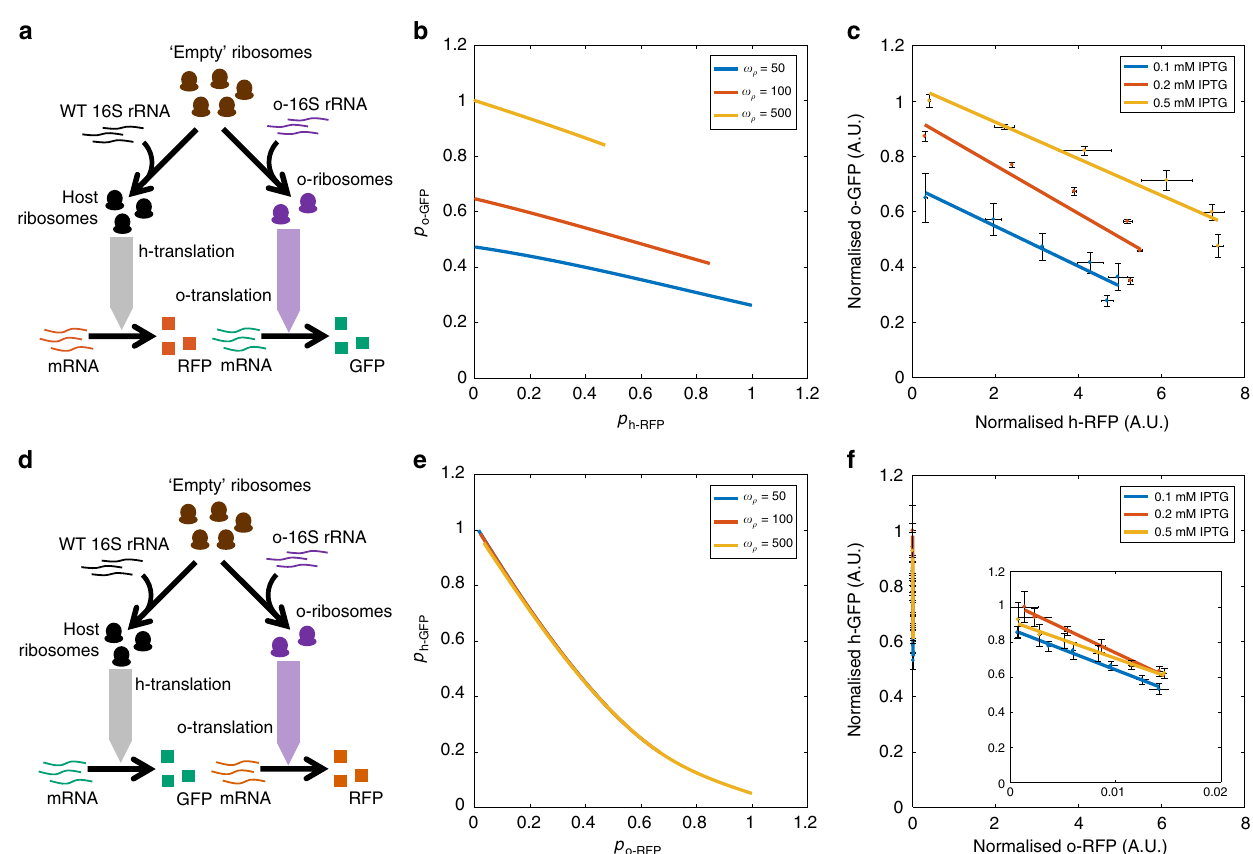
Fig. 3 Gene coupling in circuits utilising different ribosome pools. Simulations of the steady-state concentrations of RFP and GFP normalised by the maximum protein production achieved across the o-rRNA transcription rates tested. ω GFP = 100 and ω RFP = 1 to 10 3 mRNAs per min. o-rRNA production ( ω ρ ) was simulated at the rates shown. Experimental data was produced by inducing RFP using AHL from 0 to 20 nM. Points are mean steady-state fl uorescence ± 1 SD normalised by maximum GFP expression obtained across different levels of IPTG treatment. N = 3. Raw data is shown in Supplementary Fig. 8. The isocost line is fi t to the mean fl uorescence as determined by FACS from cultures during mid-exponential growth (between 3 and 5 h post-induction dependent on the strain and circuit) and gradients calculated shown in Supplementary Fig. 9. o-ribosome production was induced using three different IPTG concentrations 0.1, 0.2 and 0.5 mM as shown. a Allocation of ribosomes in b , c . b Simulations of the circuit using host ribosomes for RFP expression and o-ribosome for GFP expression. c In vivo coupling of the h-RFP-o-GFP circuit. FACS pro fi les are shown in Supplementary Fig. 14. d Allocation of ribosomes in e , f . e Simulations of the circuit using the o-ribosome for RFP expression and host pool for GFP. f In vivo coupling of the o-RFP-h- GFP circuit. The inset shows the data on an expanded x -axis. FACS pro fi les are shown in Supplementary Fig.